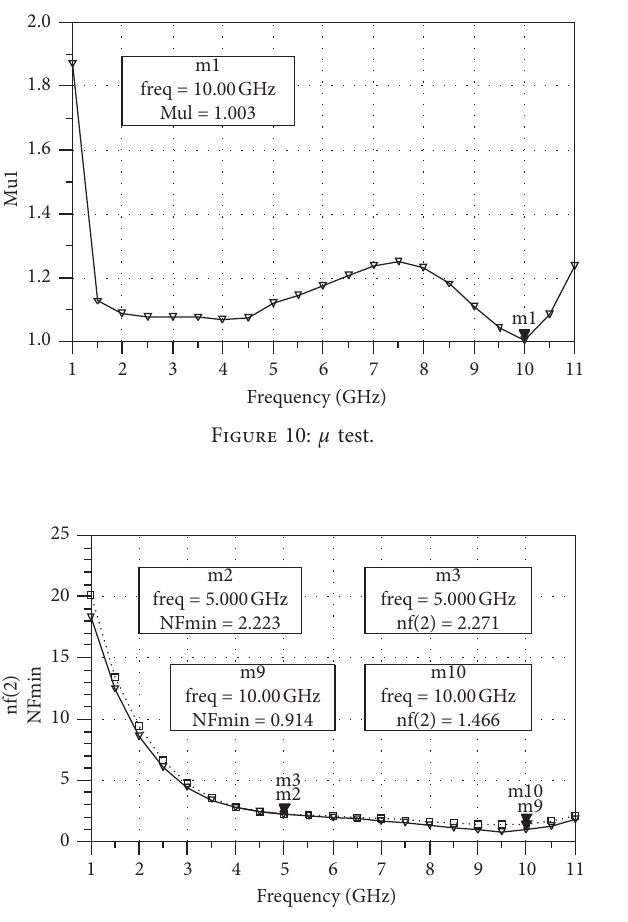
Figure 11: Noise figure and noise figure minimum.